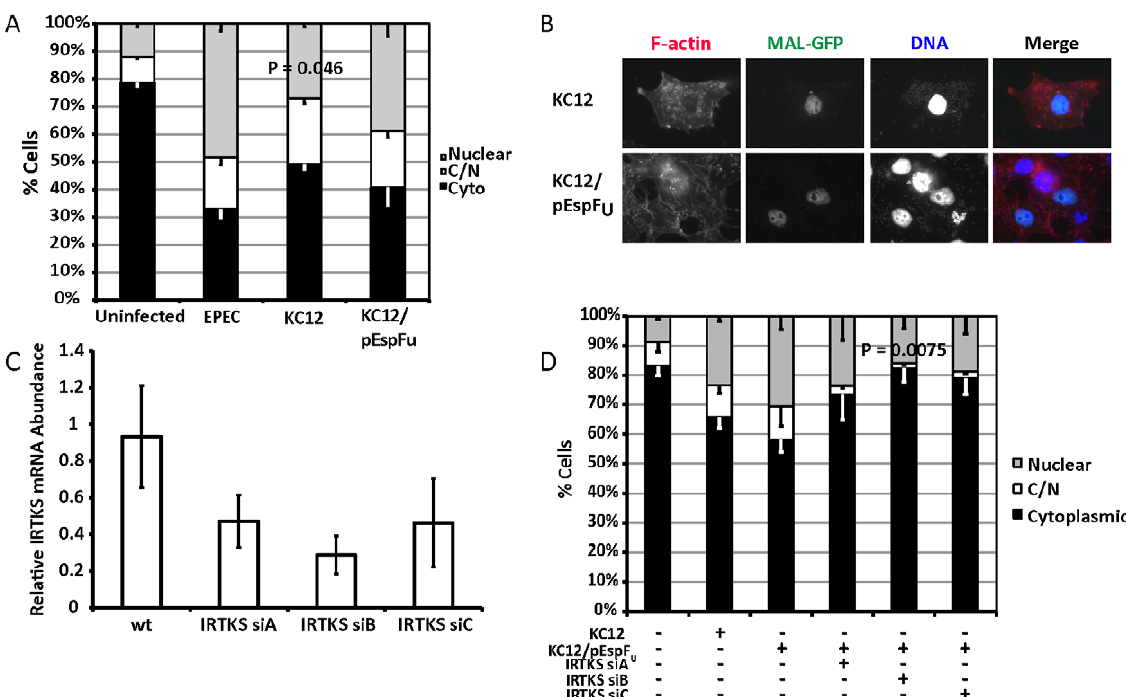
Figure 5. Tir EHEC can rescue the EPEC D tir loss of MAL-GFP translocation. A. Cellular distribution of MAL-GFP in serum-starved COS-7 cells infected with bacteria as indicated. Data are the means of at least 3 experiments where a minimum of 150 transfected cells were counted for each condition of each experiment. Values are means 6 standard deviation. B. Representative images of pedestal formation induced by Tir EHEC rescue strains. C. COS-7 cells transfected with siRNA targeting IRTKS. After 72 hours knockdown efficiency was assessed using real-time quantitative RT-PCR with IRTKS specific primers and normalized to GAPDH . Shown are means of three experiments 6 standard deviation. D. Cellular distribution of MAL- GFP in IRTKS knockdown cells infected with KC12 pEspF U . Data are means of three experiments 6 standard deviation. Scale bar=20 m